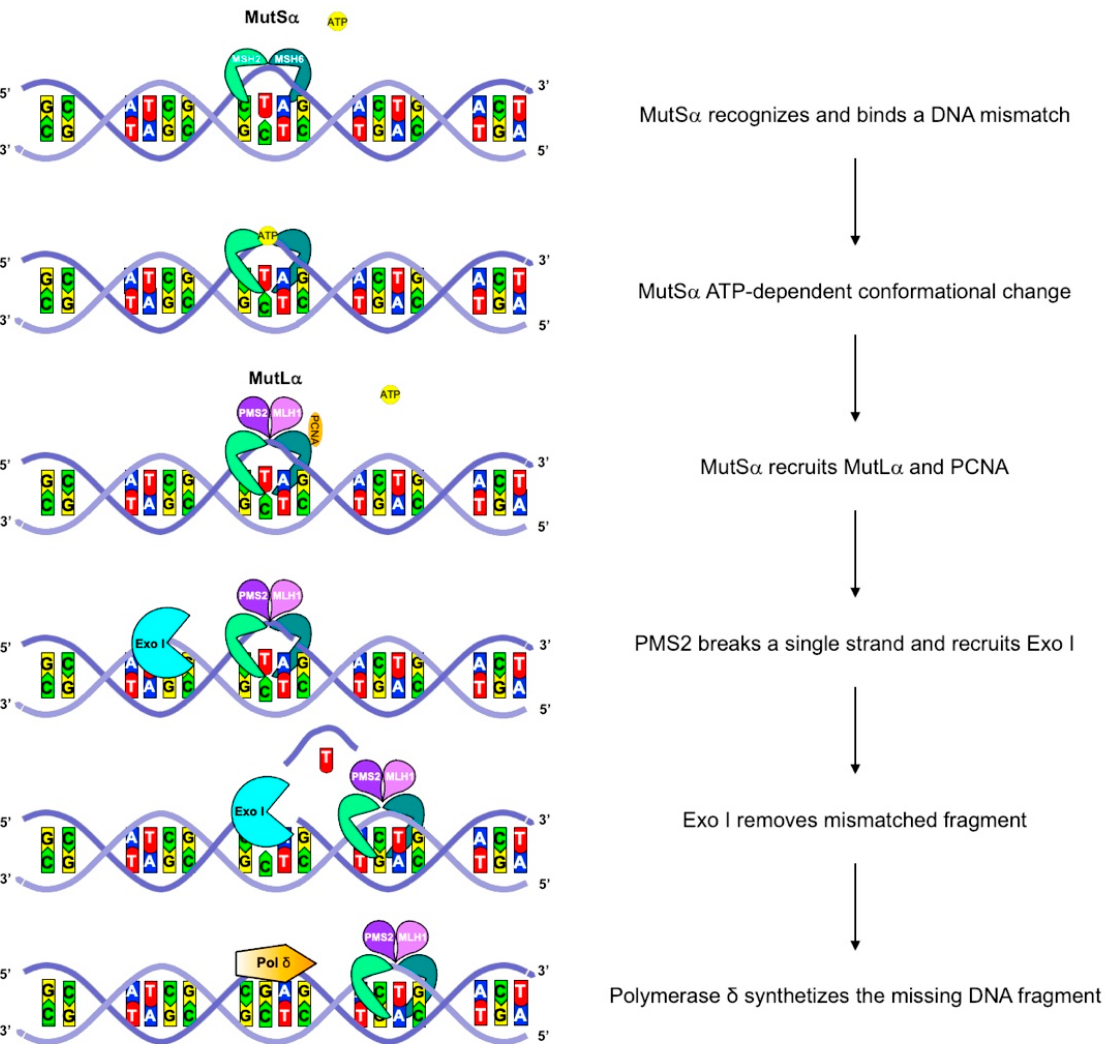
Figure 1. A schematic representation of the MMR machinery. In humans, the MMR machinery comprises nine conserved core proteins that are four MutL homologues, MLH1, MLH3, PMS1, and PMS2, and five MutS homologues, MSH2, MSH3, MSH4, MSH5, and MSH6. These proteins form hMutL heterodimers, composed of MLH1-PMS2 (hMutL α ), MLH1-PMS1 (hMutL β ), and MLH1-MLH3 (hMutL γ ). Both hMutL α and hMutL γ participate in insertion/deletion loop (IDL) repair, but single-base mismatches are mainly repaired by hMutL α . hMutS heterodimers constitute the mismatch-binding factors. Specifically, hMutS α is formed by MSH2 and MSH6 and binds single-base mispairs and IDLs, whereas hMutS β is composed of MSH2 and MSH3 and mainly acts on IDLs. After binding, MutS undergoes an ATP-driven conformational change, allowing to recruit a hMutL heterodimer. The hMutS–hMutL complex recognizes a mismatched sequence, triggering the degradation of the nascently synthesized DNA by exonuclease I (exo I) and the correct sequence synthesis by polymerase δ